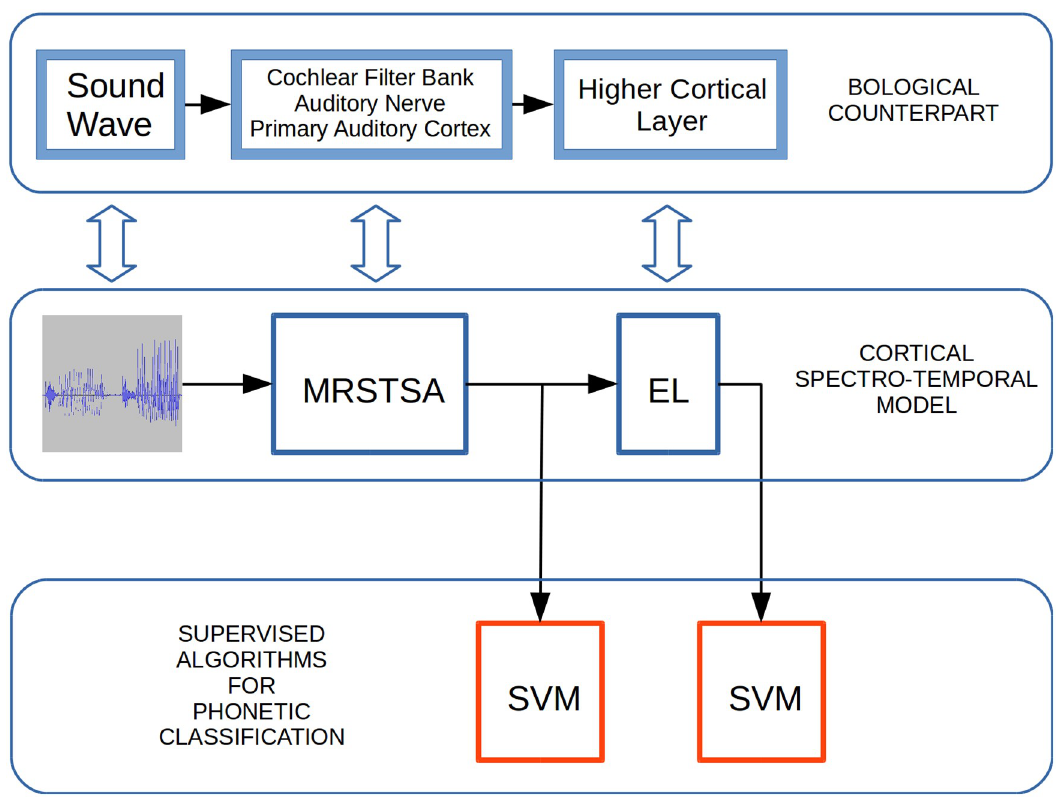
Fig 8. Experimental setup to test word classification task performances. Sound waves are processed by the MRSTSA algorithm. The outputs from the MRSTSA are processed by the EL. Word classification tasks are performed on both outputs by the SVM algorithm. Each section in the CSTM has its biological